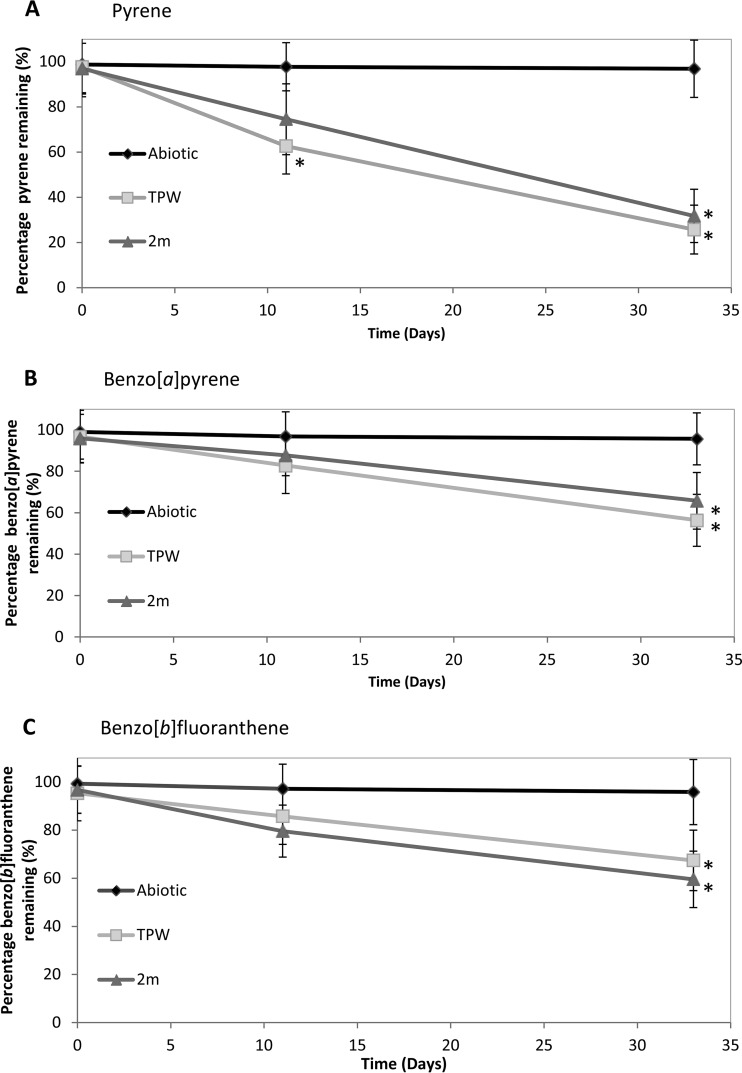
Biotransformation of HMW-PAHs by the microbial communities derived from samples TPW and 2m. Enrichments were grown on Pyr (A), BaP (B), and BbF (C). Error bars represent the standard error of the mean (n = 3). *, significant degradation compared to abiotic control (Mann-Whitney U test, P < 0.05).